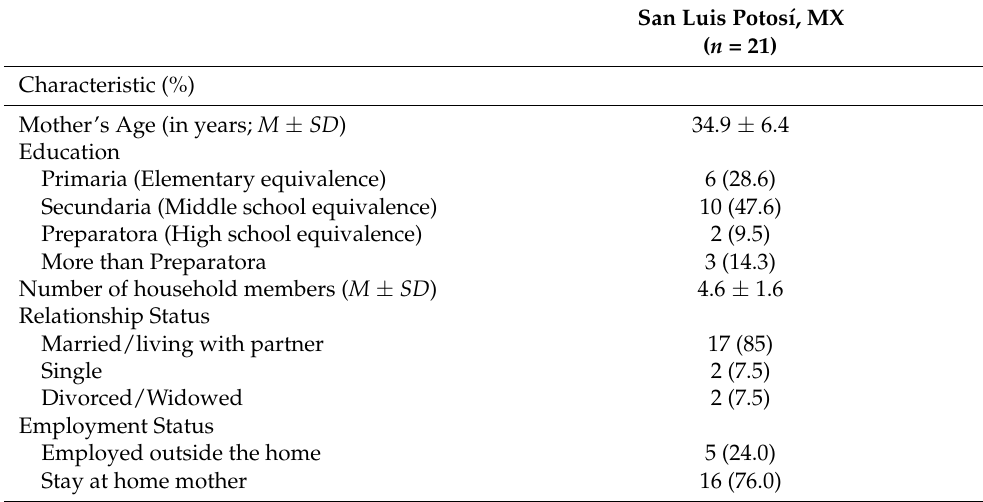
Table 1. Demographic Characteristics of Focus Group Participants ( n =